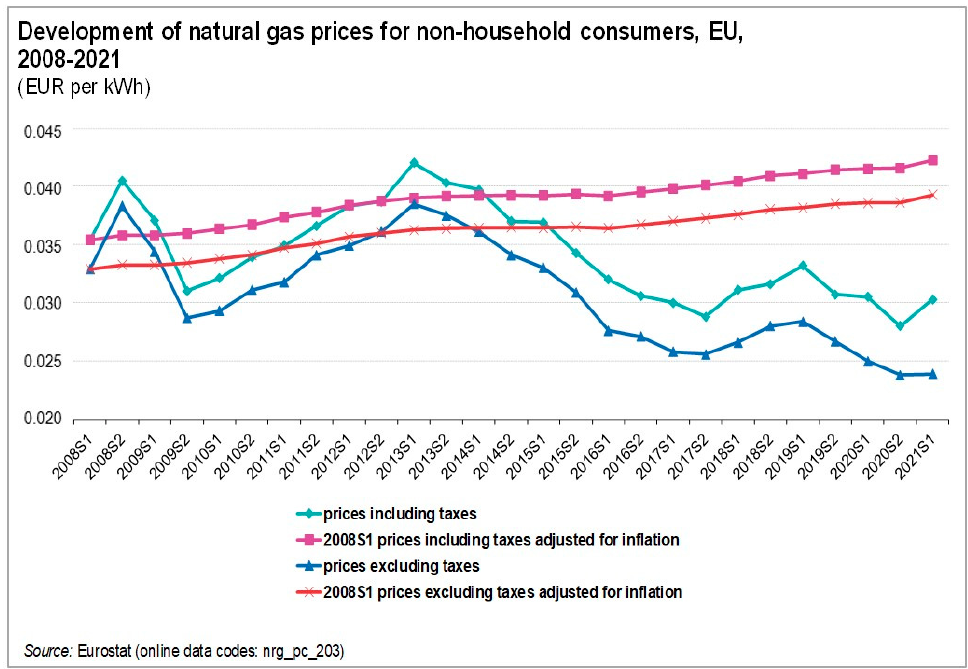
Figure 8. Development of natural gas prices for non ‐ household consumers, EU, 2008–2021 [29].